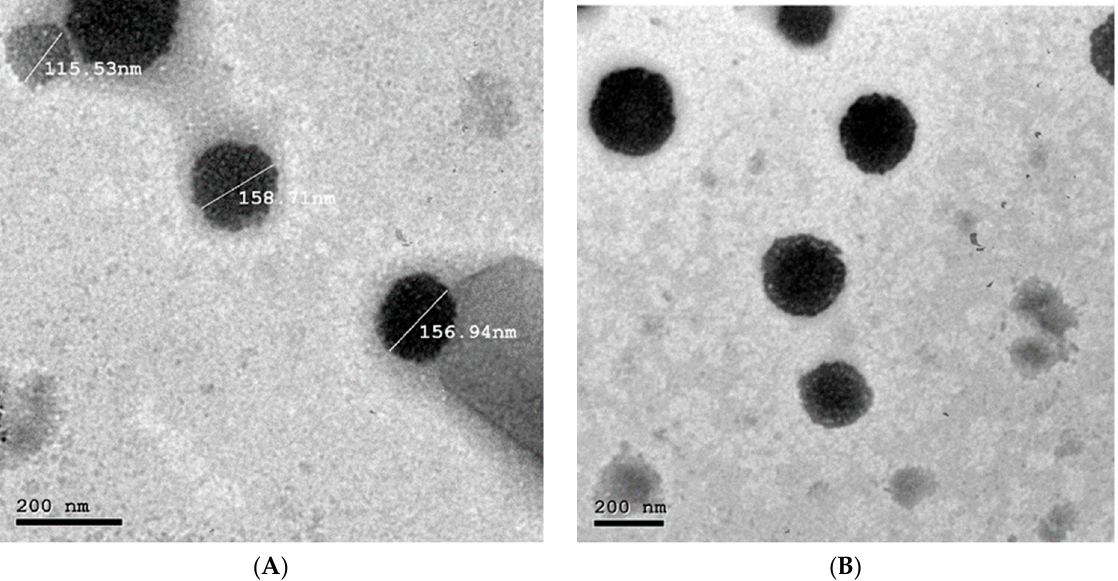
Figure 6. Transmission electron microscope image of the optimized zolmitriptan NLC (NLC9), ( A ), with scale, ( B ), without